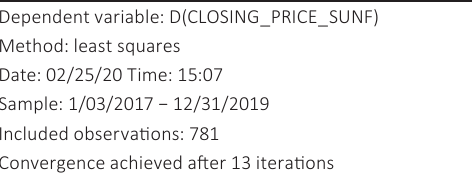
Table 3. Result of the selected model for Sun Pharmaceutical Industries